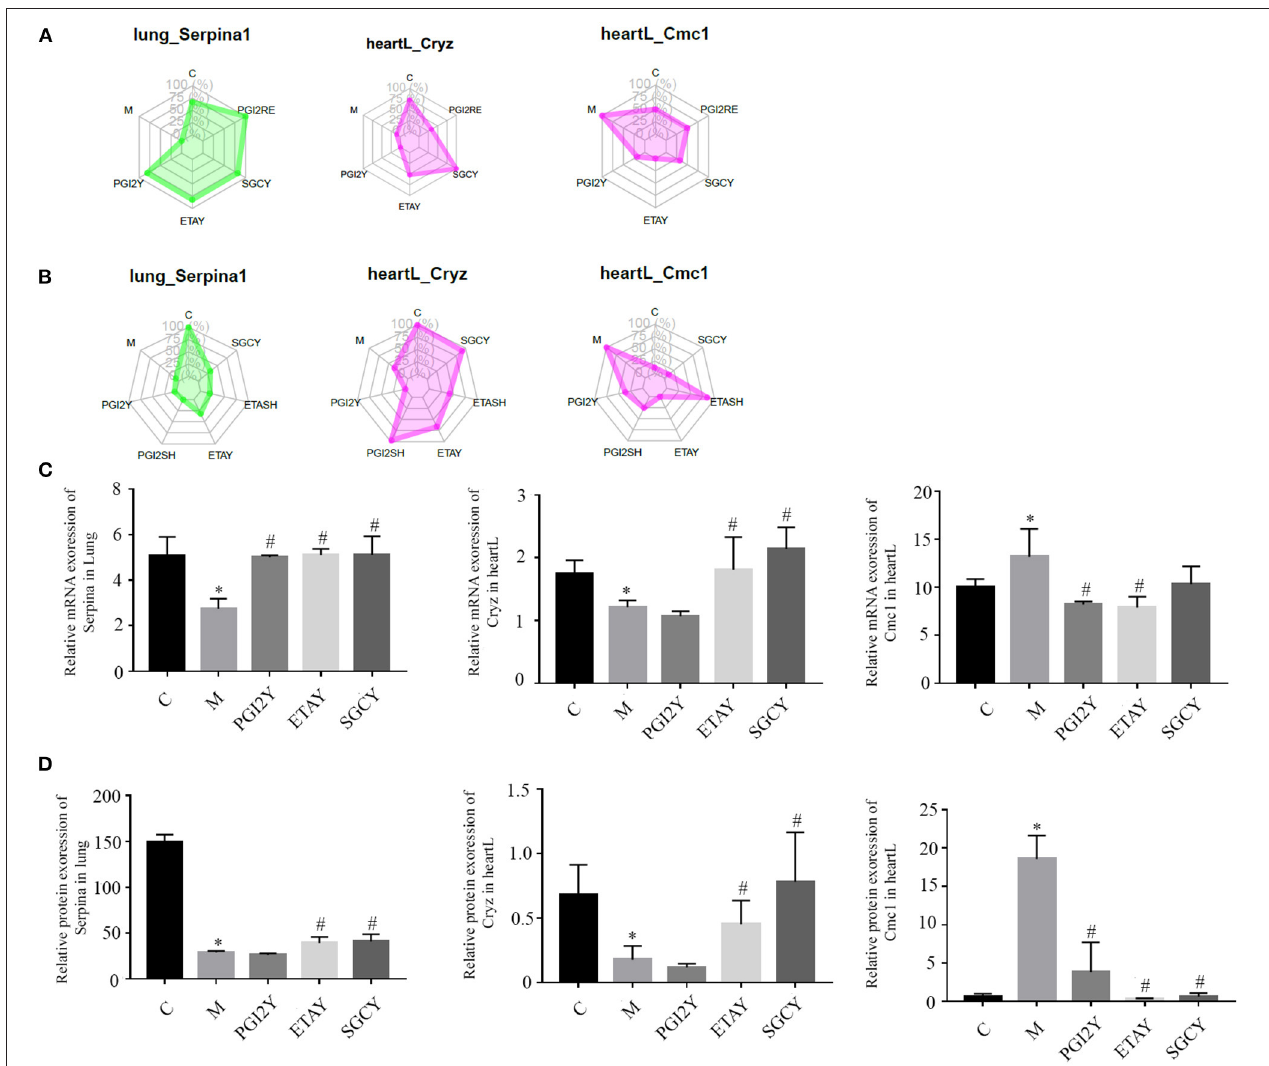
FIGURE 5 | Hub molecules with consistent co-expression patterns in the multi-omics datasets. Relative expression levels of Serpina1, Cryz, and Cmc1 in corresponding modules based on (A) RNA-seq data and (B) protein data. Relative expression of (C) mRNA and (D) protein, of Serpina1, Cryz, and Cmc1. heartL, the left heart. * P < 0.05 vs. control, # P < 0.05 vs.